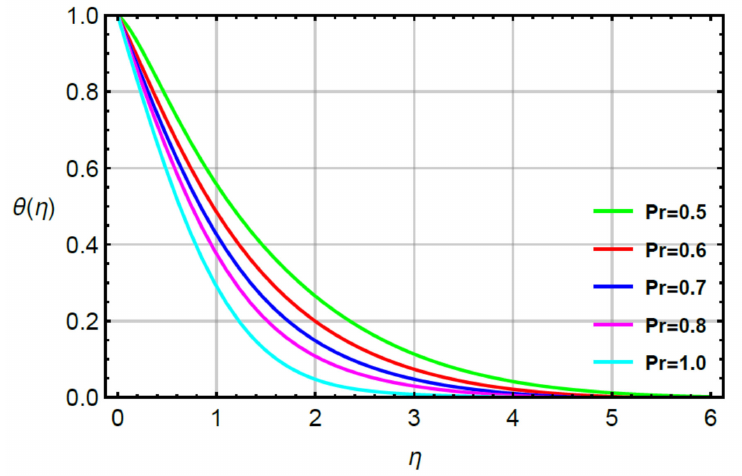
Figure 9. Behavior of θ ( η ) for Pr when R = 0.1, Sc = 0.6, α 1 = 0.2 = α 2 , γ 2 = 0.3, M = 0.1, δ =